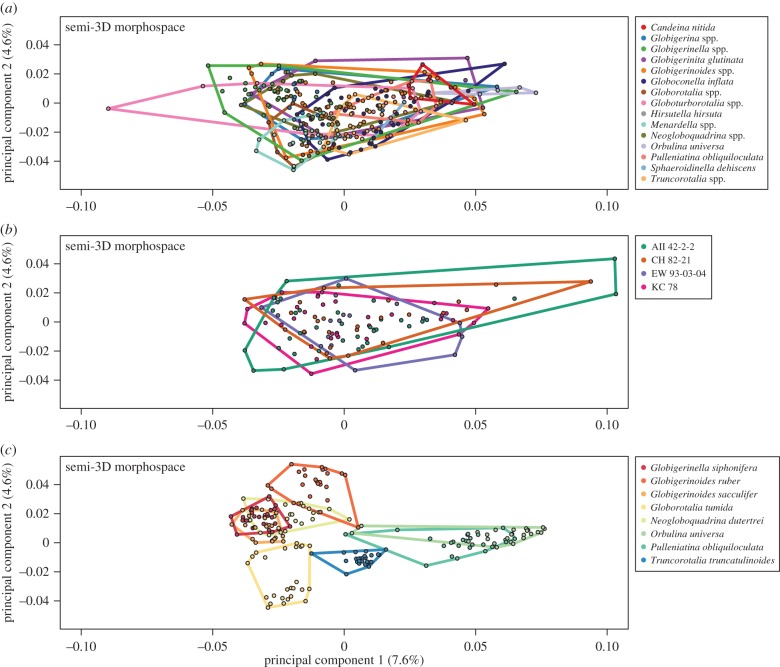
Morphospace generated from the 597 specimens that comprise our novel coretop/exemplar dataset, aligned using the Boyer et al. automatic 3D geometric morphometrics algorithm [91]. (a) The 281 species-identified coretop/exemplar individuals, grouped by genus to aid visualization (note: Trilobatus sacculifer grouped with Globigerinoides); (b) the 116 individuals from four Atlantic coretops; (c) the 200 reproducibility test individuals. Coloured lines define convex hulls for each genus/coretop/species. All three morphospaces are plotted on the same axes (PC1 versus PC2) and scale.